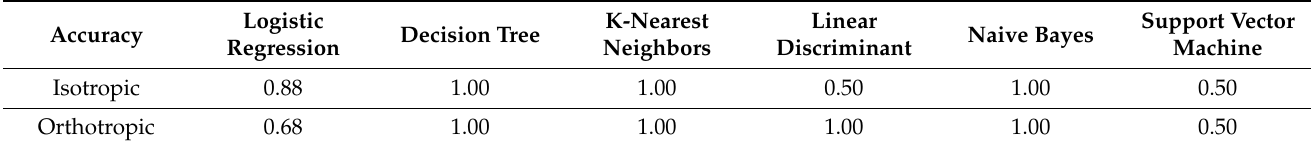
Table 5. Accuracy values for different machine learning algorithms applied on the 3D test datasets for isotropic and orthotropic materials.